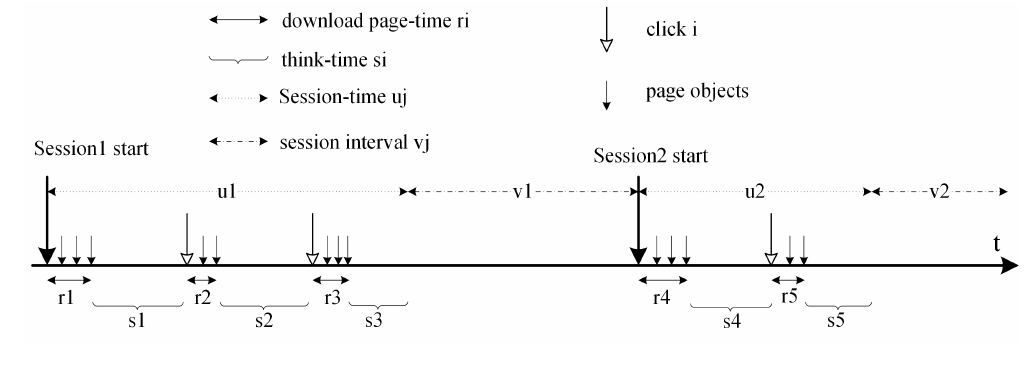
Figure 2. User browsing